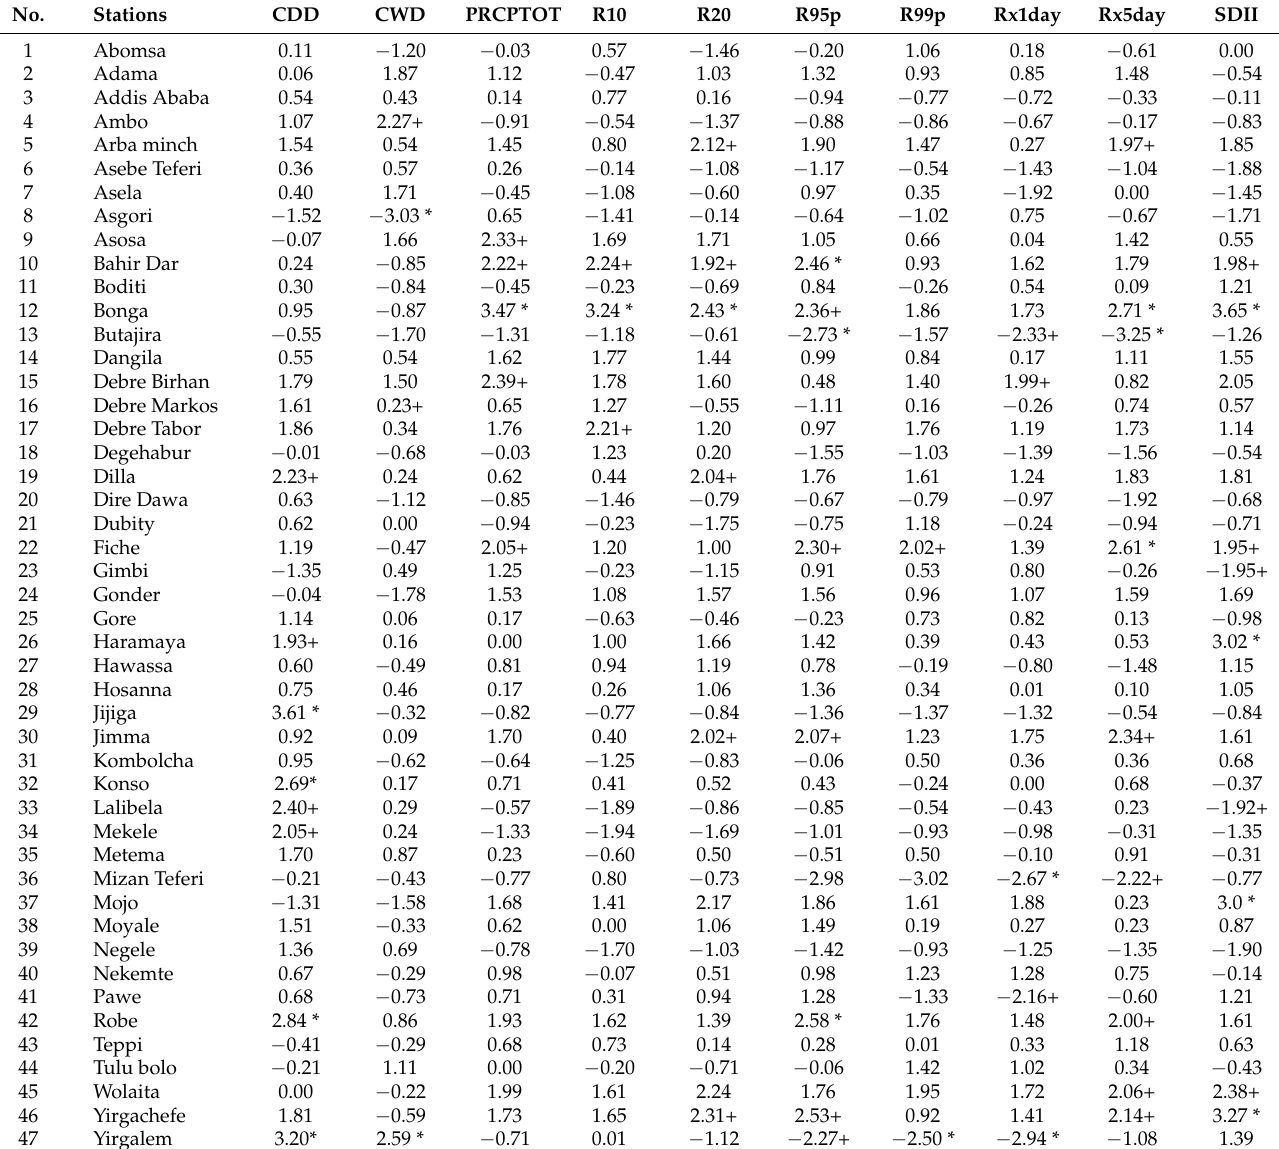
Table 3. The trends of extreme rainfall indices at different stations of Ethiopia.